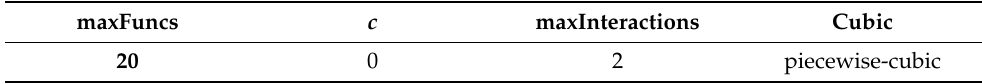
Table 3. Parameters of multivariate adaptive regression splines (MARS)